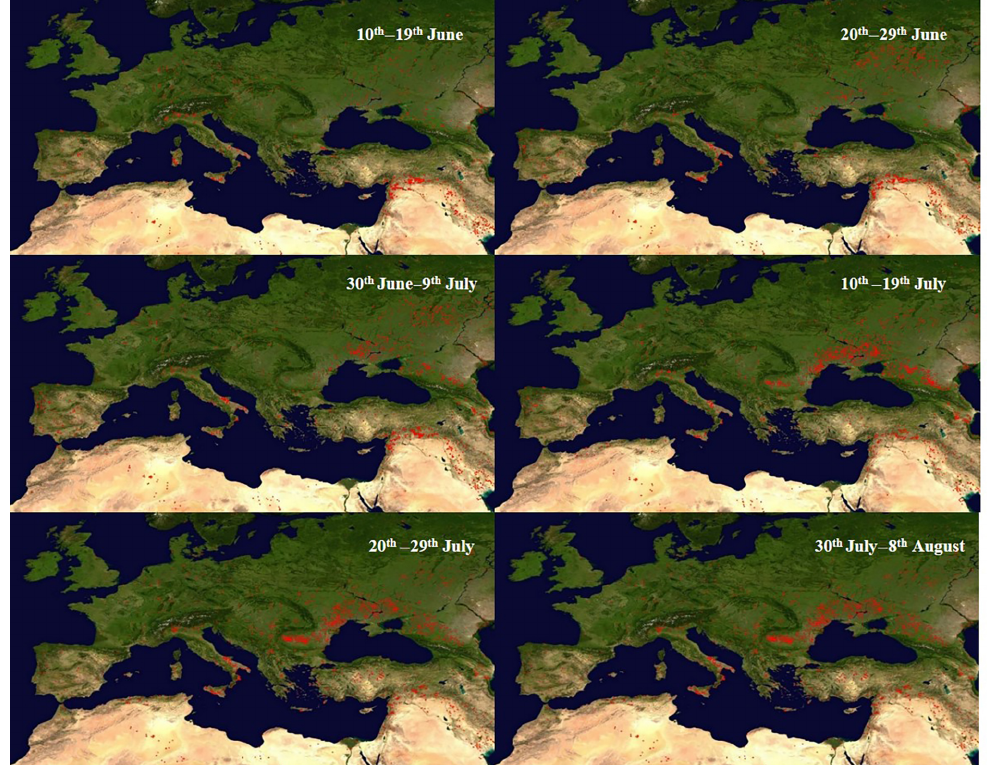
Figure 5. Locations of fires detected by the MODIS sensor on board the Terra and Aqua satellites over 10-day periods during ADRIMED and SAF-MED. Each red dot indicates a location where at least one fire was detected (http://lance-modis.eosdis.nasa.gov/cgi-bin/imagery/